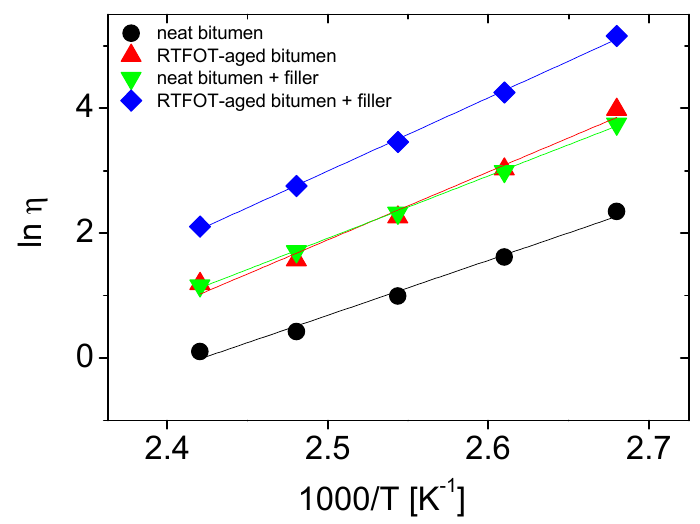
Figure 2. Arrhenius plot of the investigated samples. Uncertainties associated to the data are at most of the same order of the point size.